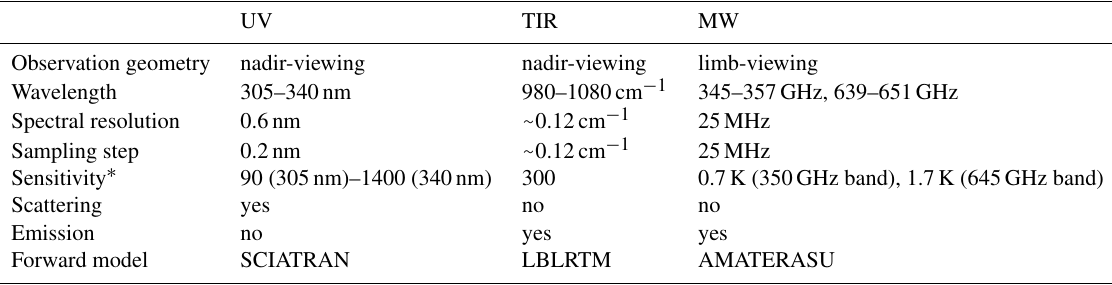
Table 1. Specifications of three assumed instruments and radiative transfer models.